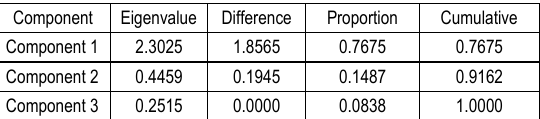
Table 2. Results of using the method of principal components to determine the indicator of